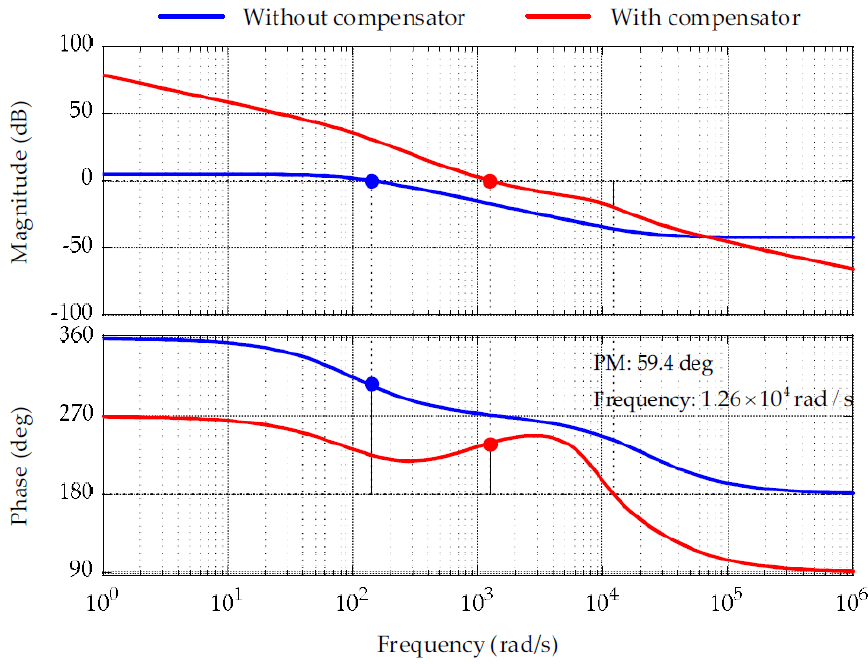
Figure 14. Bode diagram of the DC bus voltage control loop.